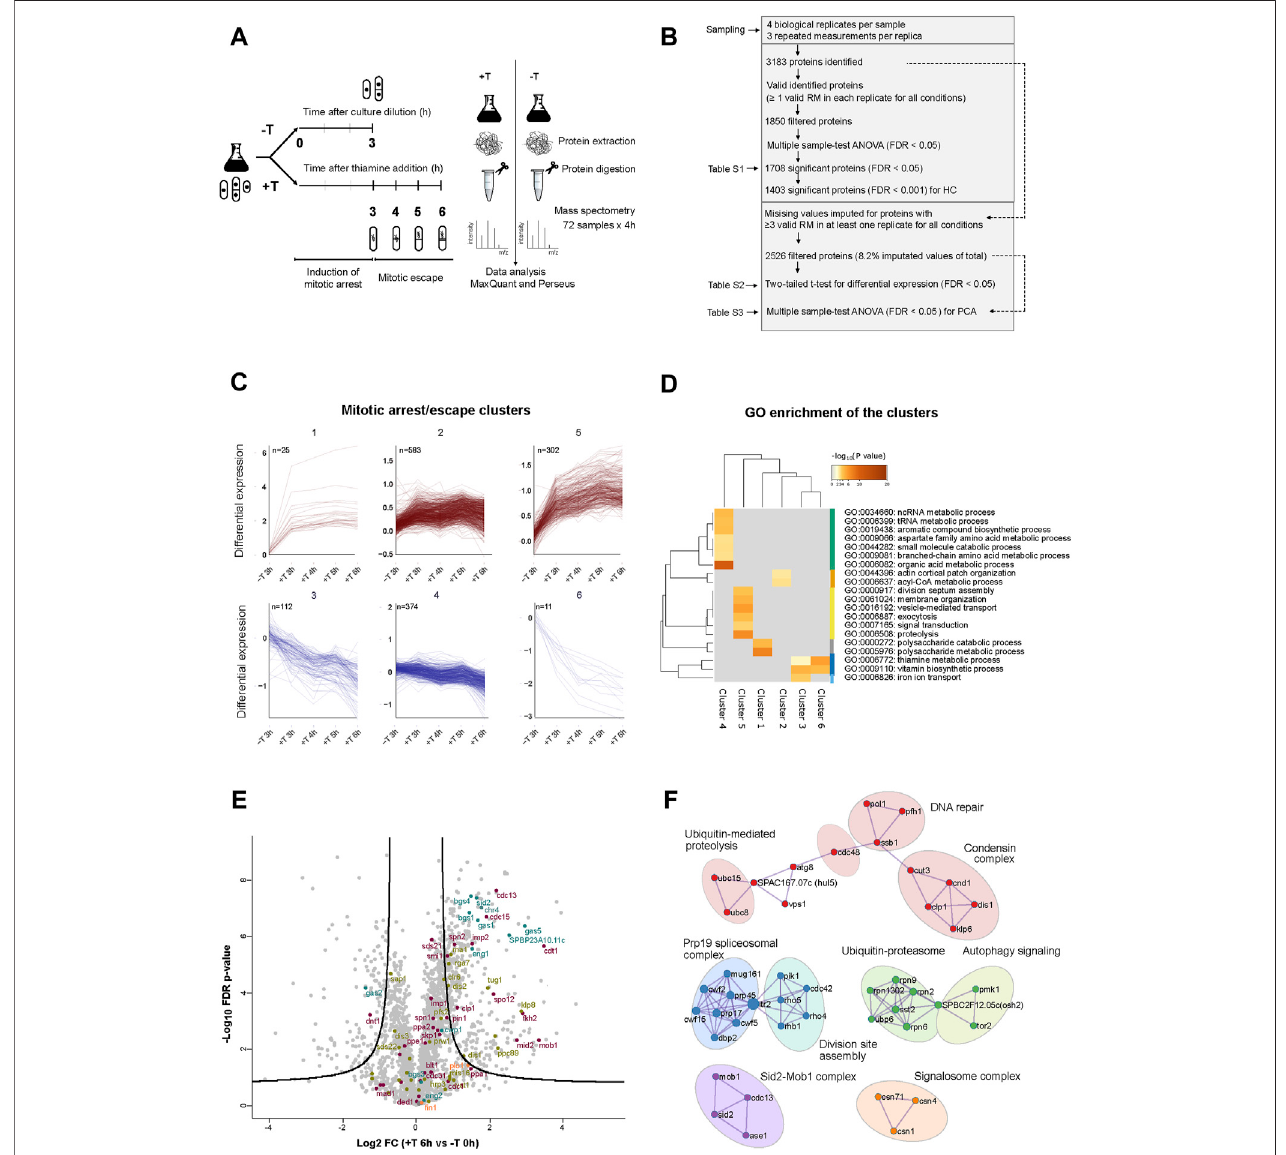
FIGURE6| Proteinsinvolvedincytokinesisaccumulateinmetaphase arrestedcells. (A) SchematicoftheMSbasedlabel-freeproteomicswork fl owtoquantifythe relative protein levels between samples of p41-nmt1:slp1 cells non-treated ( − T) and treated with thiamine (+T) in a range of 3 – 6 h, to characterise the proteome of the mitotic arrest and escape induced by the thiamine-regulatable slp1 expression system. The work fl ow is divided in four parts: (i) sampling (ii) protein extraction and digestion(iii)MSanalysis(iv)identi fi cationandquanti fi cationofproteinsusingMaxQuantanddatainterpretationusingPerseus. (B) Thenumbersofproteinanalysis at each stage of the analysis applied to the experimental dataset composed by four biological replicates and three repeated measurements (RM) for each. The initial dataset contains all proteins with at least 1 valid RM in each replicate for all conditions ( Supplementary Table S1 ). The resultant signi fi cant proteins from Multiple sample-test ANOVA (FDR < 0.0001) were used for the hierarchical clustering analysis (HC). The second dataset contains all proteins with ≥ 3 valid measurements in at least one replicate for all conditions asbasis for the differential expression analysis ( Supplementary Table S2 ) and PCA ( Supplementary Table S3 ). (C) Mitotic/arrest clusters of proteins extracted from HC. 6 clusters in total. Upper clusters contain proteins with a positive dynamic expression and lower clusters contain proteins with negativedynamicexpression overthetimecourseof slp1 repression( SupplementaryTableS1 ). (D) TopGOtermsenriched incluster-wisecomparisons.Metascape; GO BP annotations, background gene list ( Supplementary Table S1 ), and a hypergeometric test with Benjamini – Hochberg correction. All GO terms are listed in Supplementary Table S4 . (E) Volcano plot. The log2 FC indicates the mean expression level for each protein. Each dot represents one protein. The line represents a cut-off of FDR < 0.01 with a S0 = 0.5. Beyond the line, black dots represent signi fi cant hits between EMM T0 and EMM +T 6 h. Dots are coloured based on GO annotations: purple, cell cycle; green, chromosome segregation; orange, cytokinesis and septation and blue, 1-3 ß-glucanase activity. (F) PPI network of the